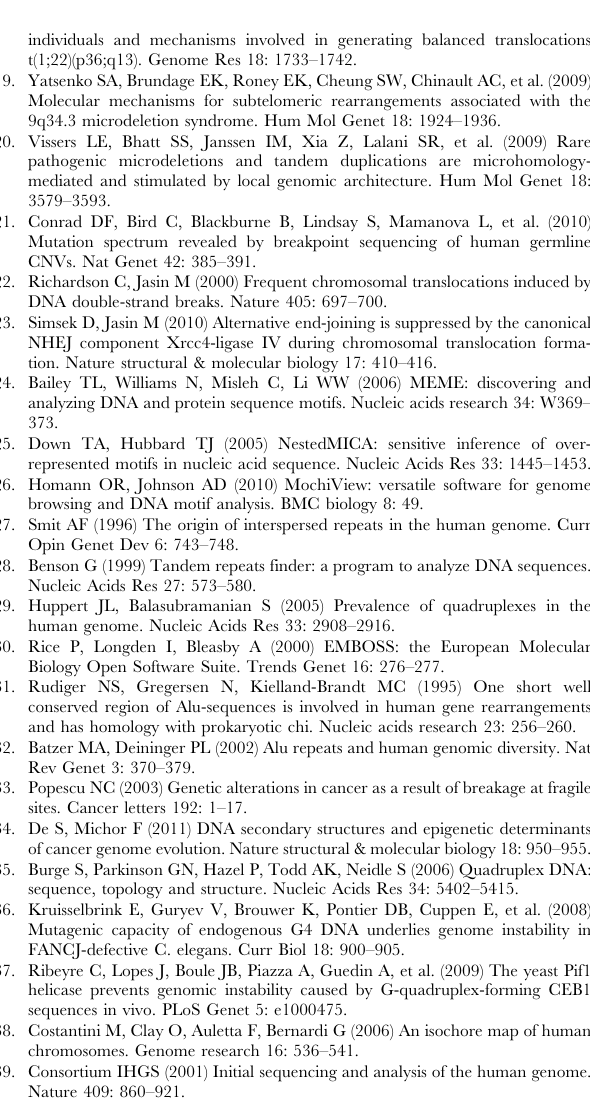
(B) and control datasets (C1-C20). The number of sequences with at least one G-quadruplex and the number of G- quadruplexes per dataset are listed. Table S6 GC content of CNV breakpoint region dataset (B) and control datasets (C1-C20). For each dataset, minimum, maximum, mean, and median percent GC were calculated.